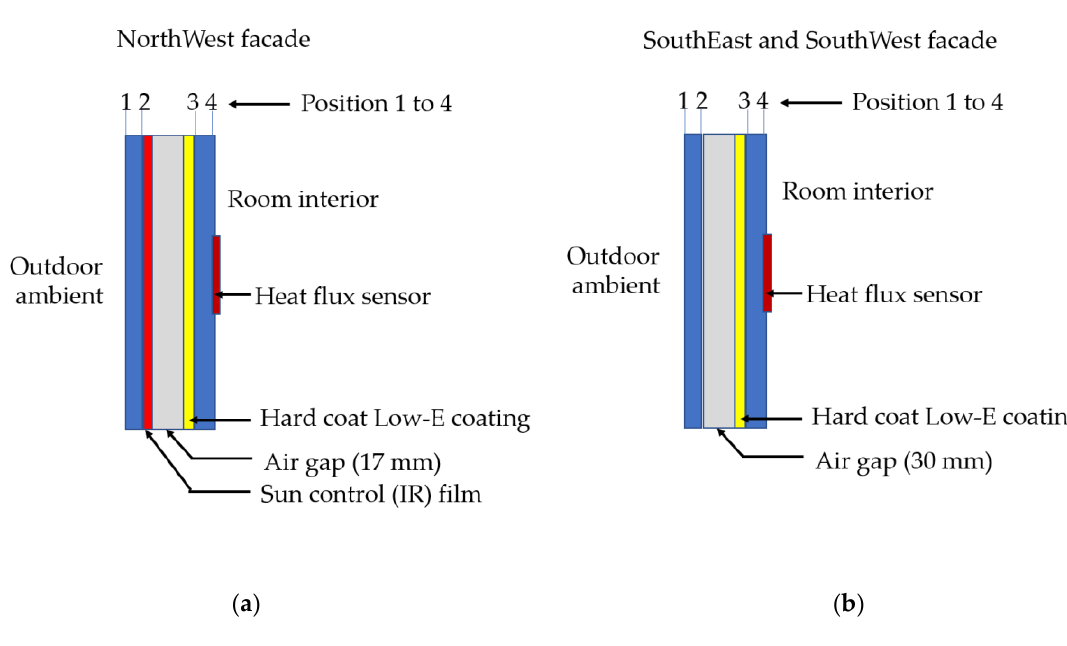
Figure 3. Schematic of installed retrofit glazing system in the NW, SE, and SW façade: ( a ) NW façade with 17 mm air gap and sun control film; ( b ) SE and SW façade with air gap of 30 mm. Table 3. Set of measured parameters with accuracy